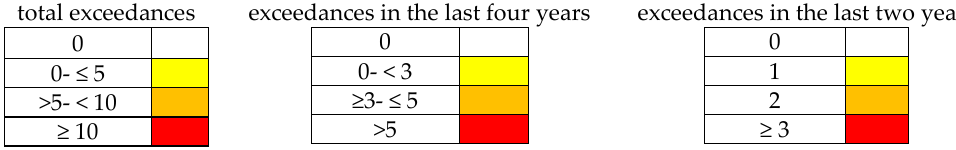
Figure 3. Georeferencing of data and production of synthetic thematic maps for immediate understanding of the status of a monitoring station. In this picture, a groundwater monitoring well is shown (PN001102); it results in a total of 12 (from 2008 to date), 6 (for annuality 2016–2019), and 4 (for annuality 2018–2019) samples analysed, with 8, 6, and 4 exceedances referred to the same periods. The total number of exceedances have been classified and coloured with the value reported in the extended legend. In detail, the exceedances are medium (n. 8 and color orange) for the period from 2008 to date, high (n. 6 and color red) for the period 2016–2019, and high (n. 4 and color red) for the period